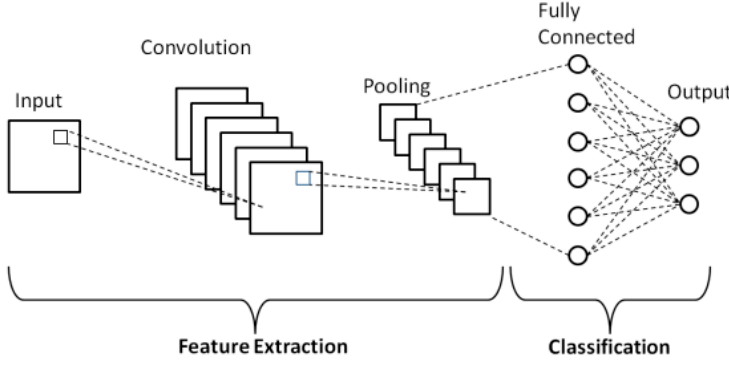
Figure 1. Schematic diagram of a basic convolutional neural network (CNN) architecture [26].